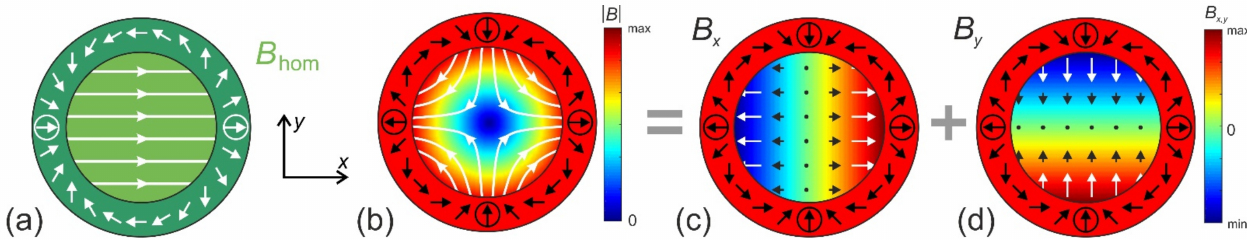
Figure 2. Sketch of ideal Halbach cylinders: ( a ) inner dipole with a homogeneous field of strength, B hom along the x -axis. ( b ) Inner quadrupole with a circular modulus field, which can be decomposed into two linear field components B x = Gx in ( c ) and B y = − Gy in ( d ). The hollow cylinders consist of permanent magnet material with continuously changing magnetization direction (arrows). The poles are encircled. In ( a , b ), the magnetic field is represented by field lines, while in ( c , d ), the arrows are field vectors (the different colors are only for better contrast). Note that the magnetic fields are only inside the hollow cylinders and that there are no stray